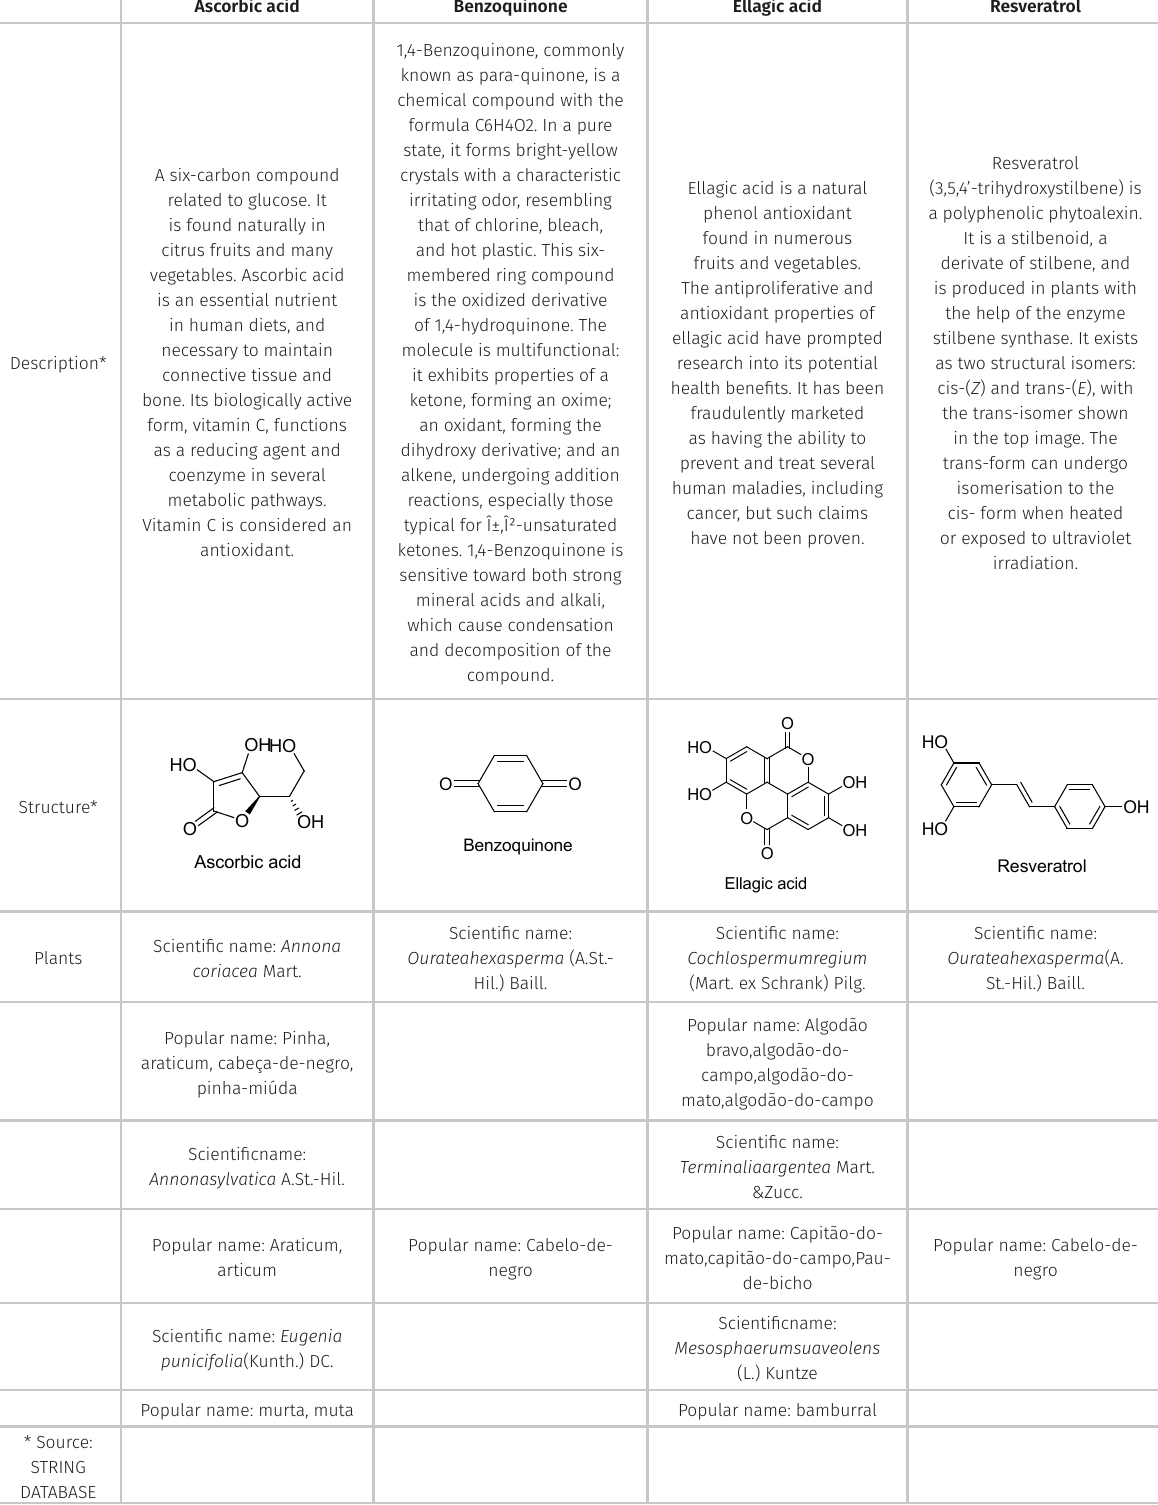
Table II. Additional information about Ascorbic acid, Benzoquinone, Ellagic acid and